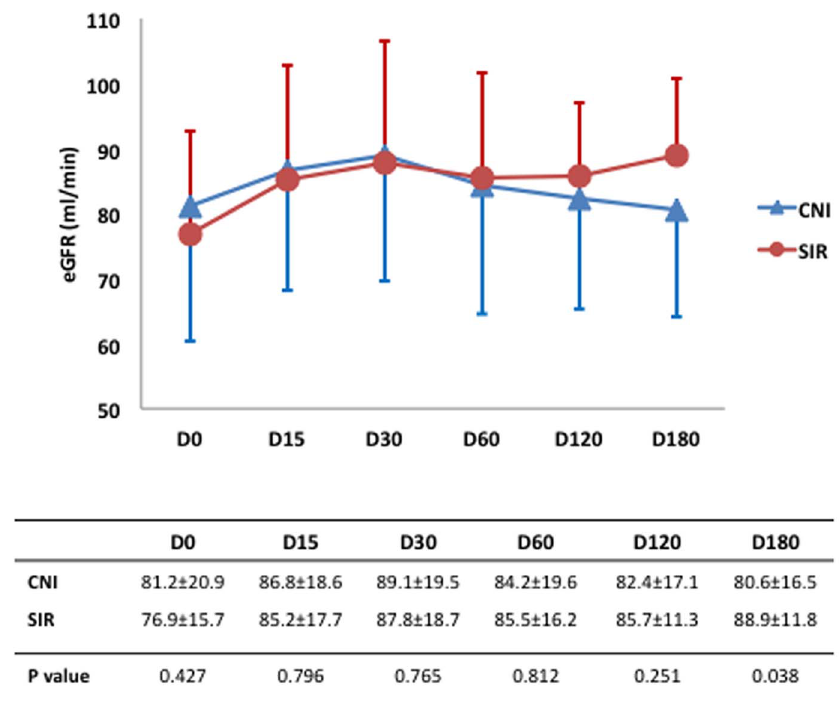
Figure 2. Graph showing estimated glomerular filtration rate (mL/min/1.73 m 2 ) at different time points in the two groups. Patients in the SIR group showed a significant improvement in GFR over baseline, and the difference between groups was significant at 6 months.